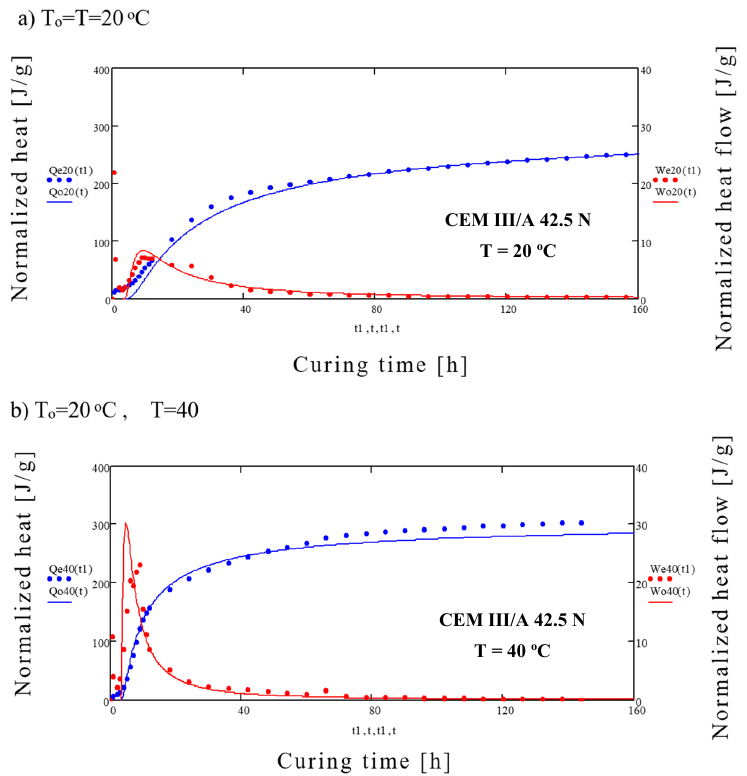
Figure 10. Comparison of experimental and calculated results of normalized heat and heat flow for the CEM III/A 42.5 N cement ( a ) for T = 20 °C, ( b ) for T = 40 °C. Relatively good compliance of the test results and calculated model was acquired in the study. Presented simple method of numerical modelling of generated heat of hydra- tion and heat flow for determined influence of temperature E n allows for the transfor- mation of the reference results to any given hydration conditions. The concept, however, requires further studies for different cement pastes and concretes cured in isometrical and adiabatic conditions. 5. Conclusions The conducted tests performed on three different types of cements have shown that replacing classic Arrhenius formula with empirical equations that take into account the influence of curing temperature on hydration heat can provide good evaluation of sus- ceptibility of those cements to temperature changes. Results of this study have shown that the susceptibility of cement to thermal conditions changes with the development of hy- dration process. Mean values of the susceptibility parameter determined for the first 7 days of hydration vary for different cement class and type. The presented simplified method of numerical modelling of heat generation and generation rate for determined value of the E n parameter (influence of curing temperature on cement hydration) allows